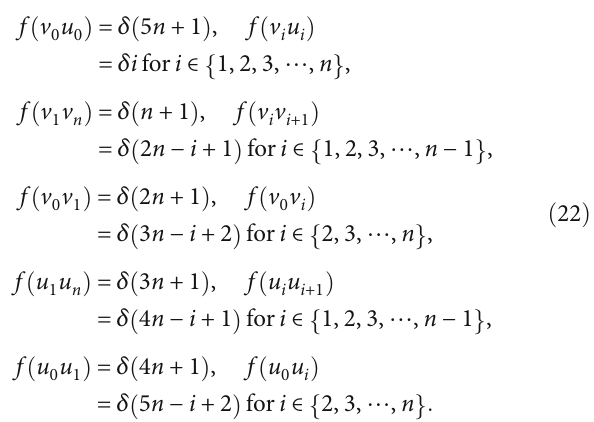
n , n with ordinary